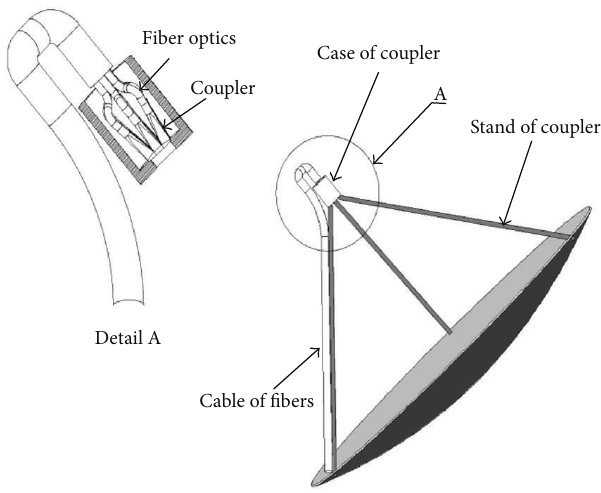
Figure 1: Schematic of a parabolic dish, coupler, and fiber optics.